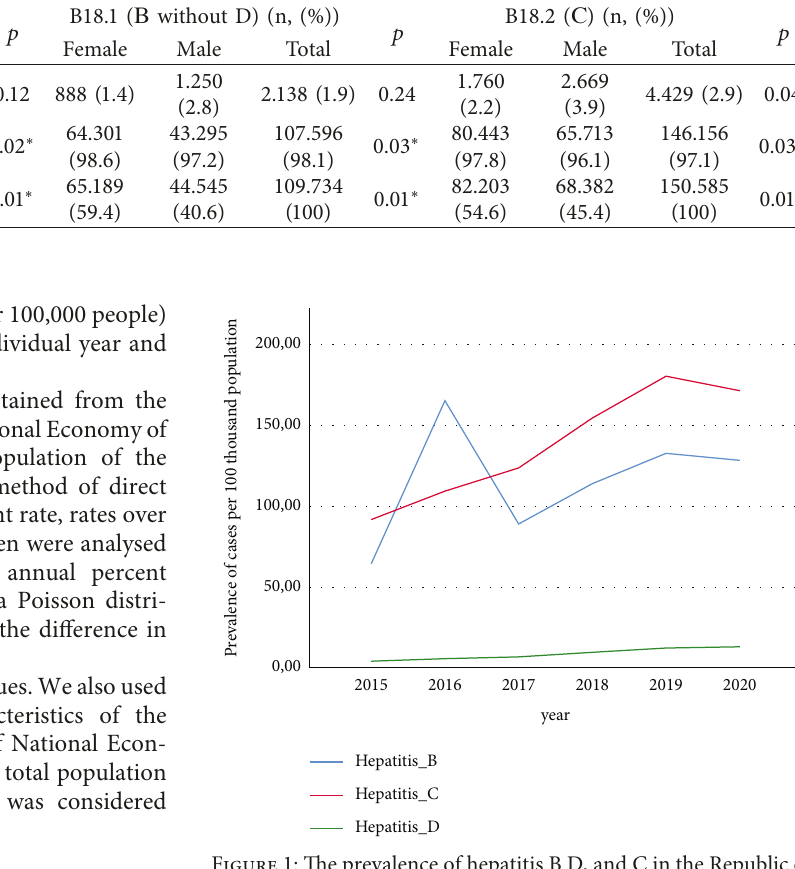
Figure 1: The prevalence of hepatitis B D, and C in the Republic